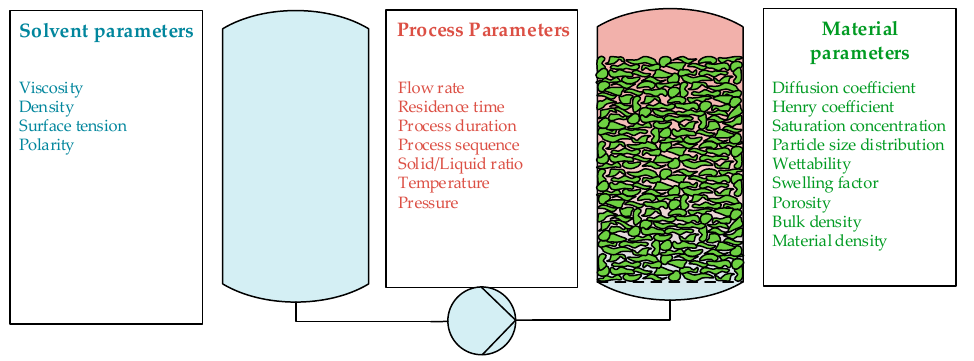
Figure 4. Relevant parameters for modeling of extraction processes.